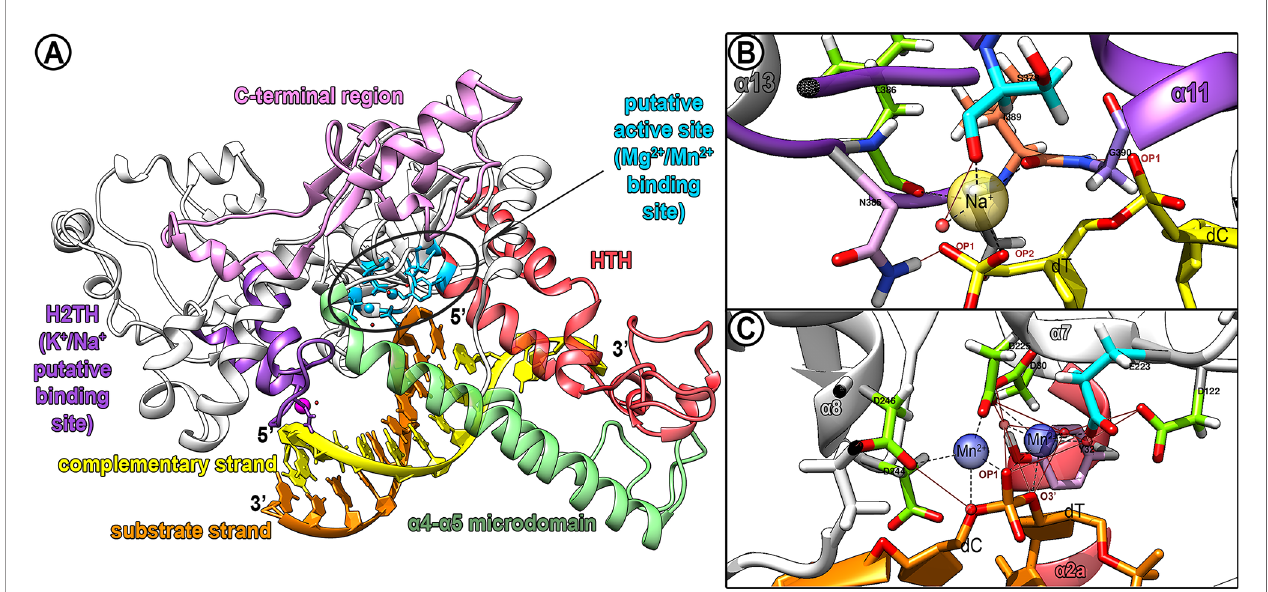
FIGURE 1 | Putative catalytic domain of LmjEXO1 and predicted interactions with substrate DNA and metallic ions. (A) Prediction of the main regions of the catalytic core of LmjEXO1 by structural alignment with HsEXO1 (SHI et al, 2017), i.e.: active site (sky blue), possibly containing sites for bivalent ligands including Mg 2+ and/or Mn 2+ (blue spheres); domain helix-two-turn-helix (H2TH, purple); with a putative monovalent ligand including sodium or potassium (magenta sphere); helix-turn-helix wedge (HTH, red); a 4- a 5 microdomain (green); C-terminal region (pink). The small red spheres constitute putative water molecules. (B, C) The inside of the predicted domain H2TH and the putative active site of LmjEXO1 were zoomed in. The side chains of the residues predicted in the coordination of the metallic ions are shown by sticks. Predicted hydrogen bonds are presented as brown lines, whereas putative pseudobonds for metallic ions coordination are displayed as dashed lines in black. Water molecules possibly involved in the interaction are shown as red translucent spheres. Oxygen atoms are shown as red sticks; nitrogen atoms are displayed as blue sticks, and hydrogen atoms are shown in white. Alpha-helixes predicted around the ligand sites are also displayed. (B) The predicted site for monovalent K+/Na+ ligands (yellow translucent sphere) is displayed. Predicted residues in the coordination: S378 (cyan); N385 (pink); L386 (green); I389 (orange); G390 (purple). Yellow sticks represent the phosphodiester backbone of the complementary strand (non substrate) of the DNA. OP1 and OP2: oxygen atoms of phosphate groups. (C) The predicted active site is displayed with two bivalent cations (Mg 2+ and/or Mn 2+ ), presented as blue translucent spheres. Residues predicted in the coordination: D30, D122, D225, D244 and D246 (green); E223 (cyan); Y32 (purple). Orange sticks represent the phosphodiester backbone of the substrate DNA